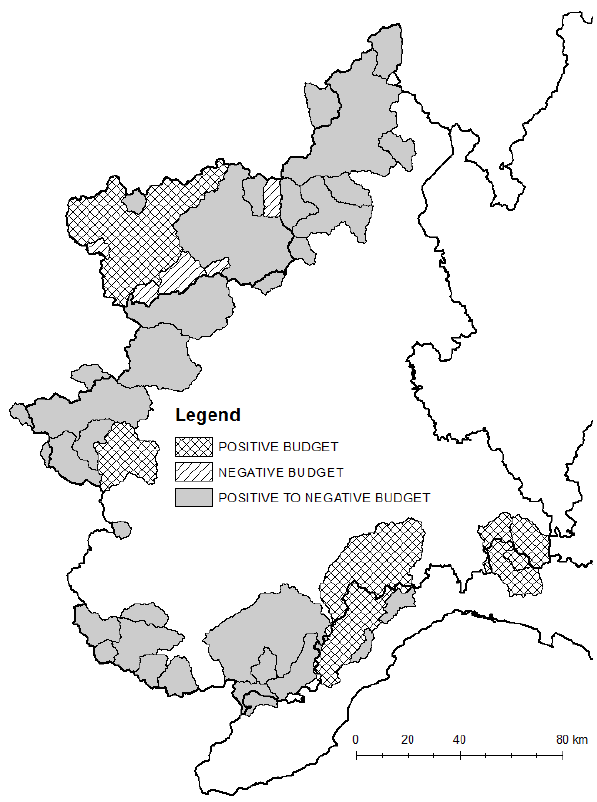
Fig. 2. Study domain and catchments used for the model applica- tion. Hatched (cross-hatched) basins are characterized by a negative (positive) budget (i.e., the difference between annual precipitation and runoff). Gray-shaded areas indicate basins with positive bud- get that becomes negative when accounting for evapotranspiration losses (i.e., P − R − ET act